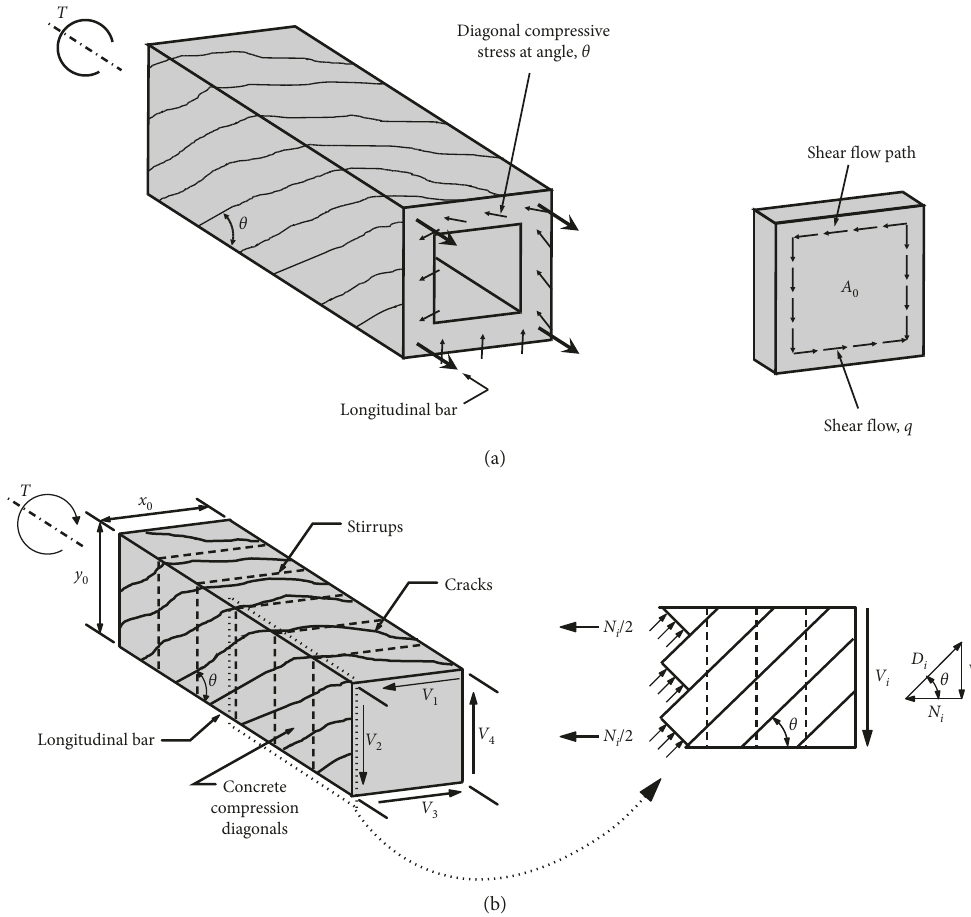
Figure 3: (a) Thin-walled tube analogy and (b) space truss analogy [3,